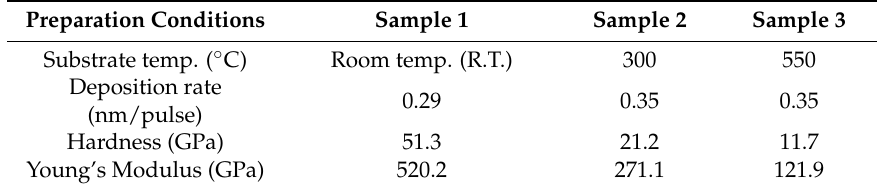
Table 1. Typical preparation conditions of the UNCD/a-C films.